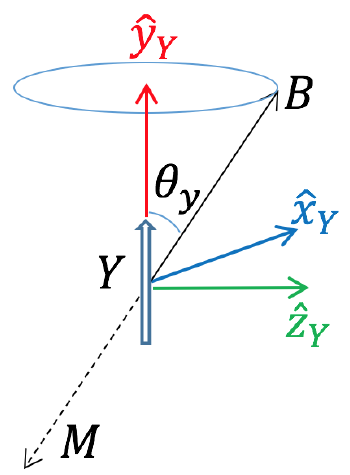
Figure 1: The Y → BM decay, with the spin direction of Y along the y